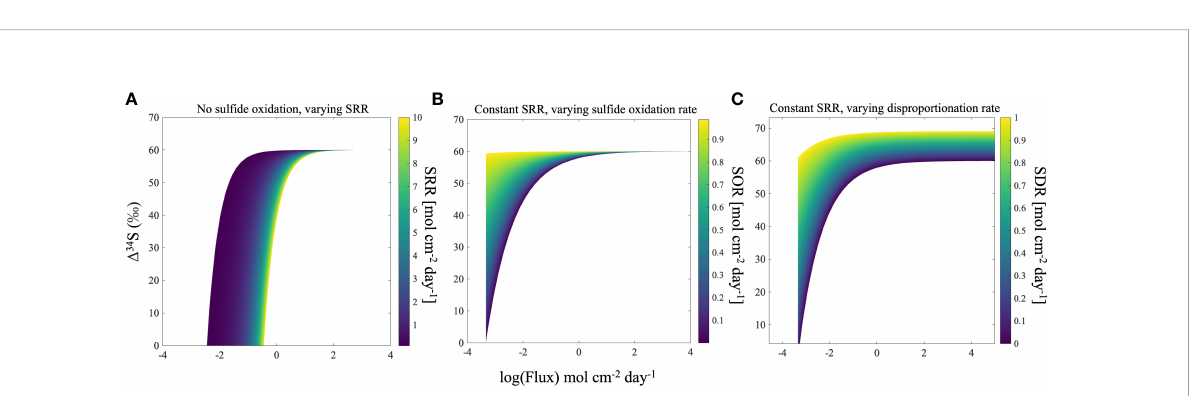
FIGURE 5 Model for D 34 S SO4_sw-H2S_pw vs. fl ux at steady state for three different scenarios: no hydrogen sul fi de oxidation in the sediment for different sulfate reduction rates (A) , dissolved sul fi de oxidation for different oxidation rates (B) , and sulfur disproportionation for different disproportionation rates (C) . All models show that D 34 S SO4_sw-H2S_pw is higher at greater fl uxes. SRR=microbial sulfate reduction rate, SOR=hydrogen sul fi de oxidation rate, SDR=sulfur disproportionation